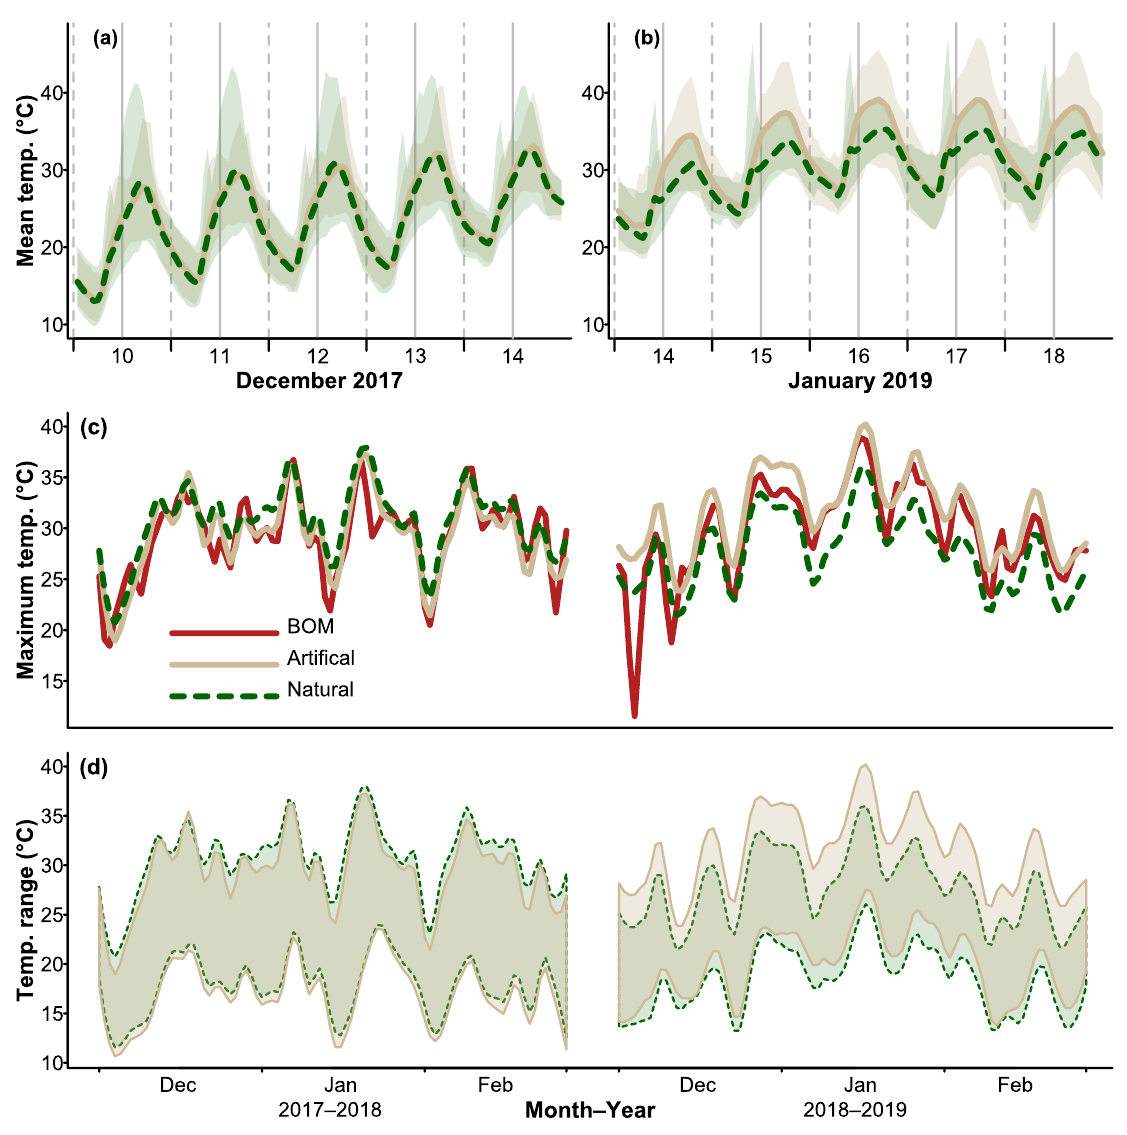
Figure 1. Mean trends in ( a and b ) mean temperature, ( c ) maximum temperature, and ( d ) temperature range. Trends were taken from an average across stations (loess smoothed for clarity). A color key is shown in middle left panel in ( c ). The Bureau of Meteorology air temperature data (BOM) shown in ( c ) represents a weighted average of maximum daily air temperatures recorded from the nearest stations to the hollow locations.